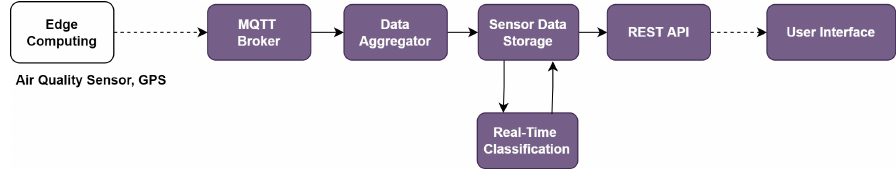
Figure 7. Function flow for air quality monitoring system in platform.